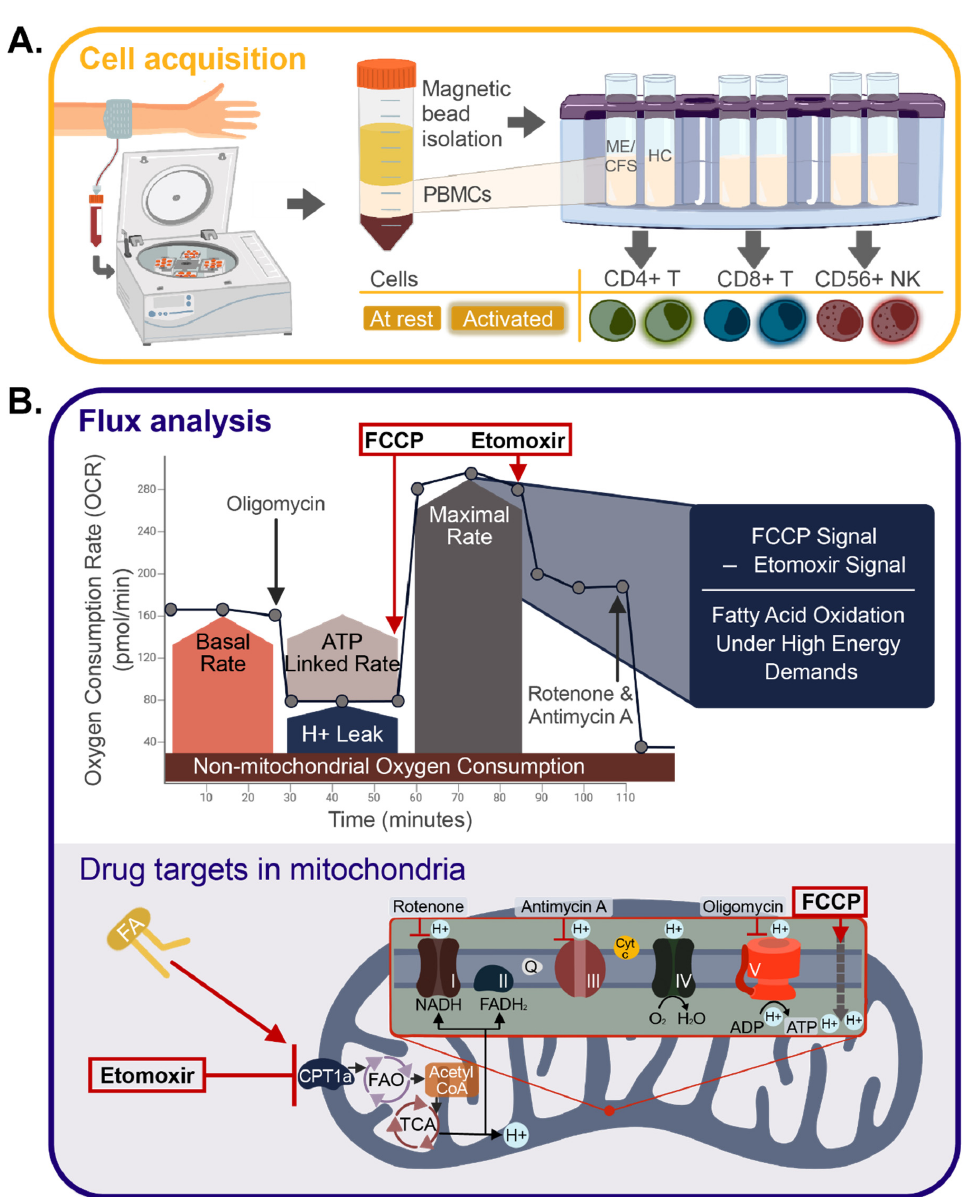
Figure 1. Immune cell isolation study design and extracellular flux analysis. ( A ) Cell acquisition approach, where peripheral blood mononuclear cells (PBMCs) were isolated from whole blood taken from both healthy controls (HC) and individuals with ME/CFS. Magnetic bead isolation was performed using positive selection, starting with CD56+ Natural Killer (NK) cells, followed by CD8+ T cells, and, finally, CD4+ T cells. Isolated immune cells were activated 24 h before the experiment with ⍺ CD3/ ⍺ CD28 and IL2 for T cells and IL15/IL12 for NK cells. ( B ) Seahorse drug injection strat- egy, where the y -axis represents the rate of oxygen consumption in pmol/minutes, and the x -axis is the time during the assay in minutes. A modified Mito Stress test drug injection strategy was per- formed on isolated immune cell types. Etomoxir, an inhibitor of fatty acid oxidation, was included in post-FCCP measurements to calculate the fatty acid contribution of each cell type under high energy demands. Included in panel B is a visual representation of each drug target within the mito- chondria (FA = fatty acid, FAO = fatty acid oxidation, TCA = tricarboxylic acid cycle).